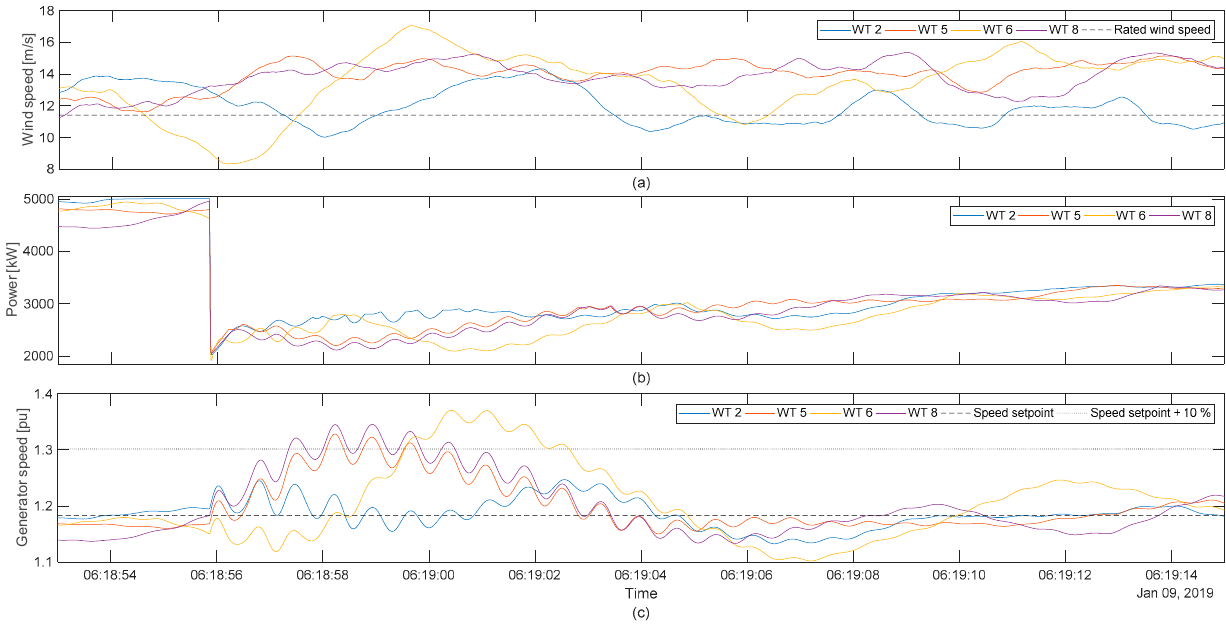
Table 3. Results of scenario I. Maximum speed and duration in overspeed for all simulated WTs. WT Number